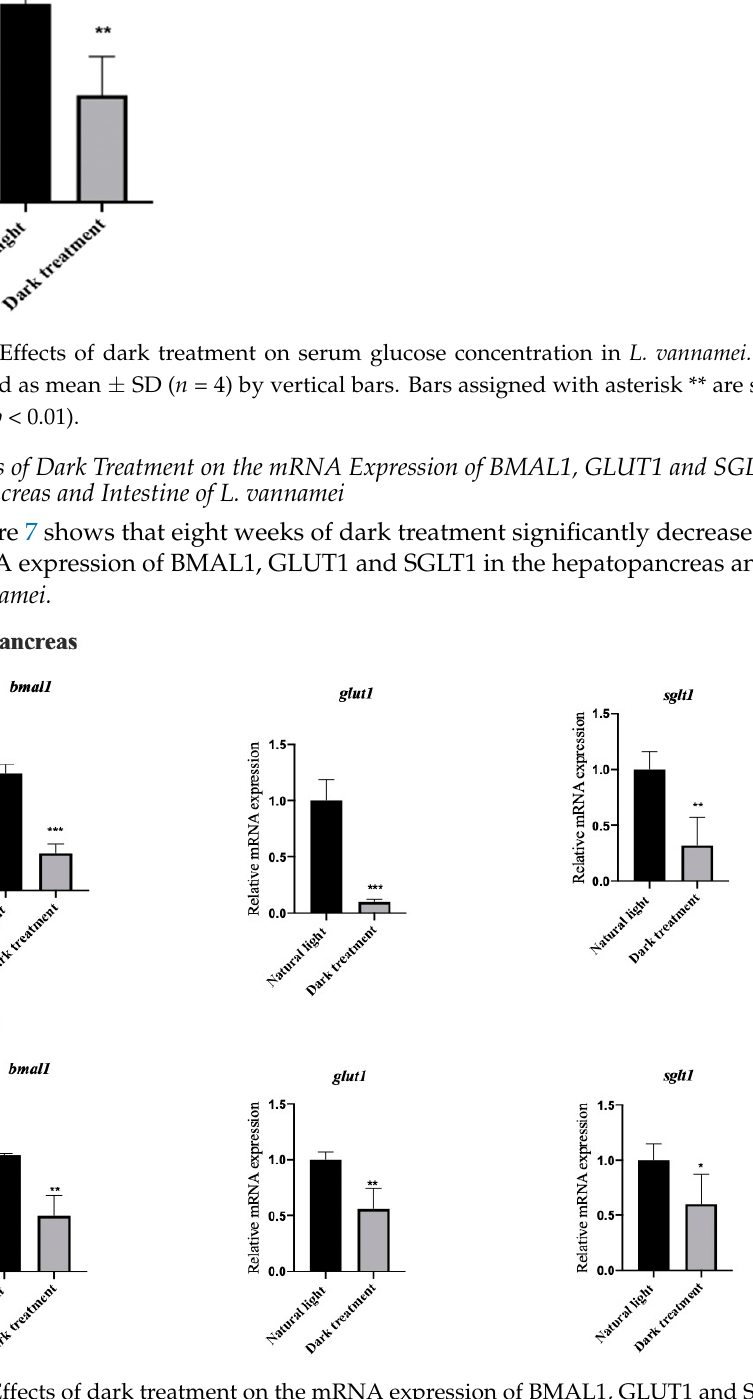
Figure 7. Effects of dark treatment on the mRNA expression of BMAL1, GLUT1 and SGLT1 in the hepatopancreas and intestine of L. vannamei. Values are represented as mean ± SD ( n = 4) by vertical bars. Bars assigned with asterisks are significantly different (* indicates p < 0.05, ** indicates p < 0.01, *** indicates p < 0.001).